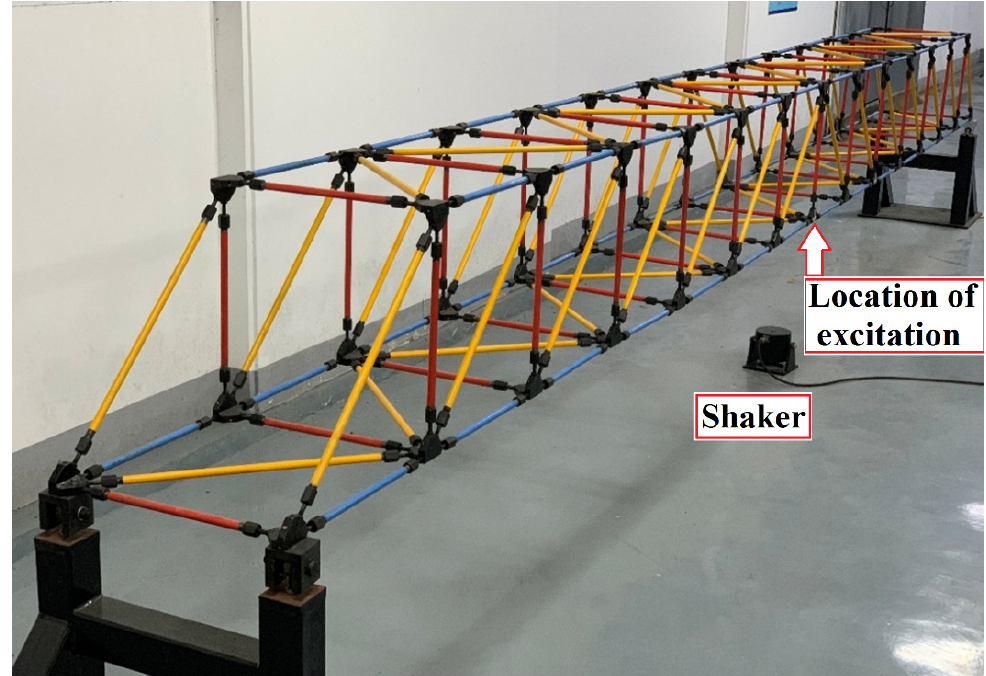
Figure 1. A perspective view of the steel truss bridge model as the case study in the present work established in the Qingdao University of Technology (QUT) laboratory.